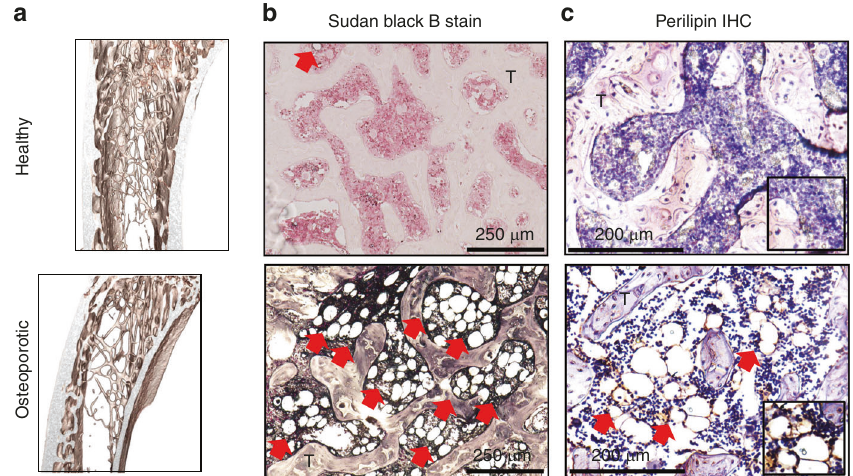
Fig. 6 Images of healthy and osteoporotic bone in a rodent model developed in normogravity. A greater level of adiposity is observed within the osteoporotic architecture. a MicroCT images showing that the trabecular architecture is slowly resorbed, leading to alterations in pore number, size and shape. b Histological images demonstrate narrowing of the trabeculae (T) and the generation of an increased level of lipids in osteoporotic bone compared with healthy tissue. Sudan Black B stained phospholipids (gray) and intracellular lipids (black). c Perilipins are found exclusively on adipocytes, and using immunohistochemistry (IHC), a greater amount of positive staining is observed within the marrow of osteoporotic bone. Positive lipid staining is indicated by red